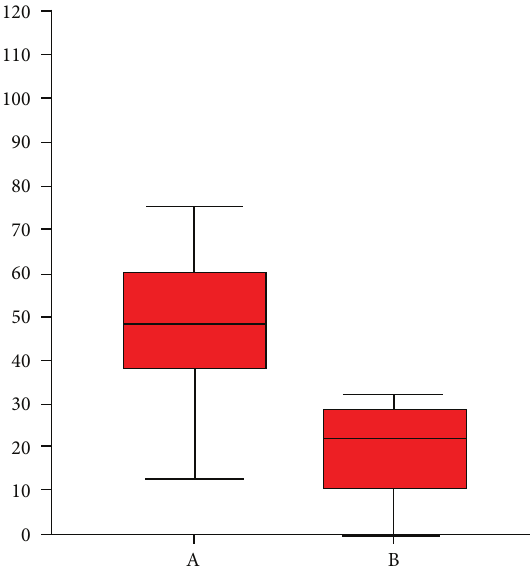
Figure 5: Percentage changes shows by means of box-plot, of the pre and post therapy DLQI score in the two groups A and B, the differencesareevaluatedusingtheMann-Whitneytest( 𝑃 < 0.0001 ).